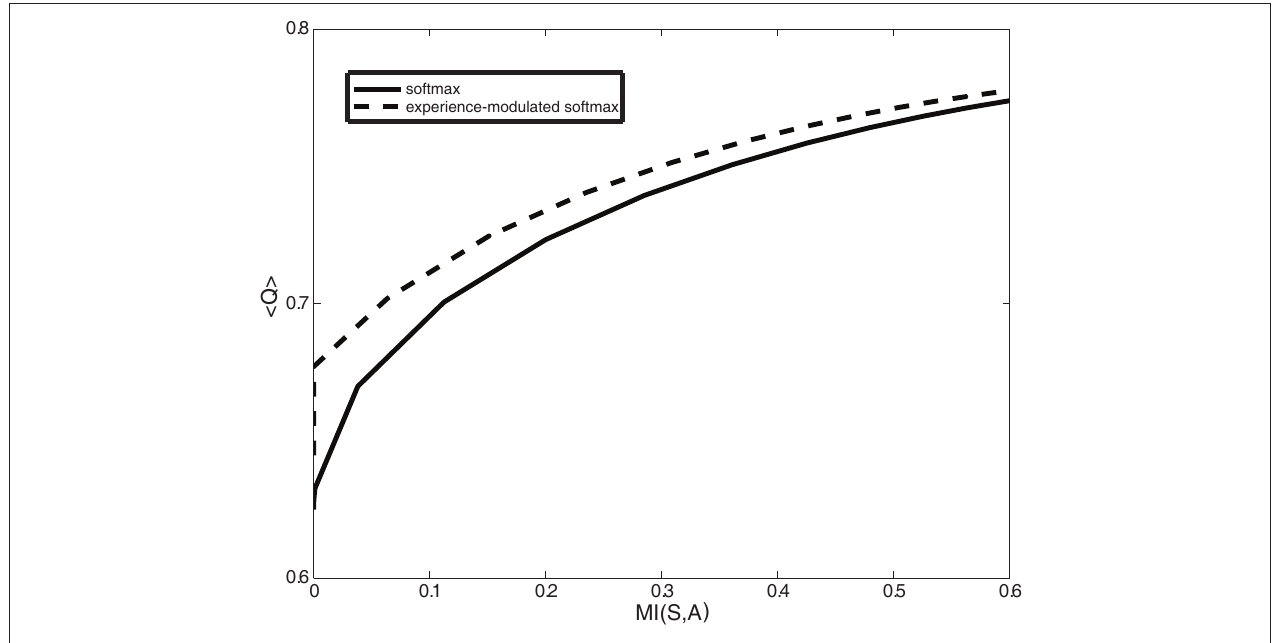
higher reward probability on the left side appear twice as often as states with a higher reward probability on the right. In this scenario, for given complexity values, the experience-modulated softmax policy yields a higher expected